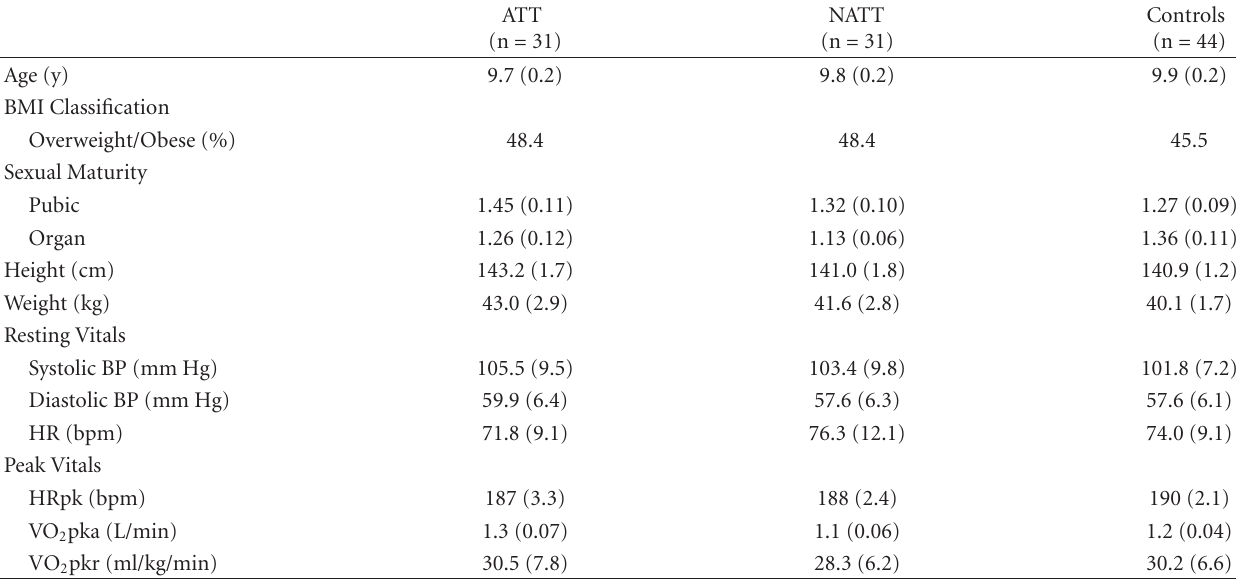
Table 1: Baseline Participant Characteristics (Means ± SE).